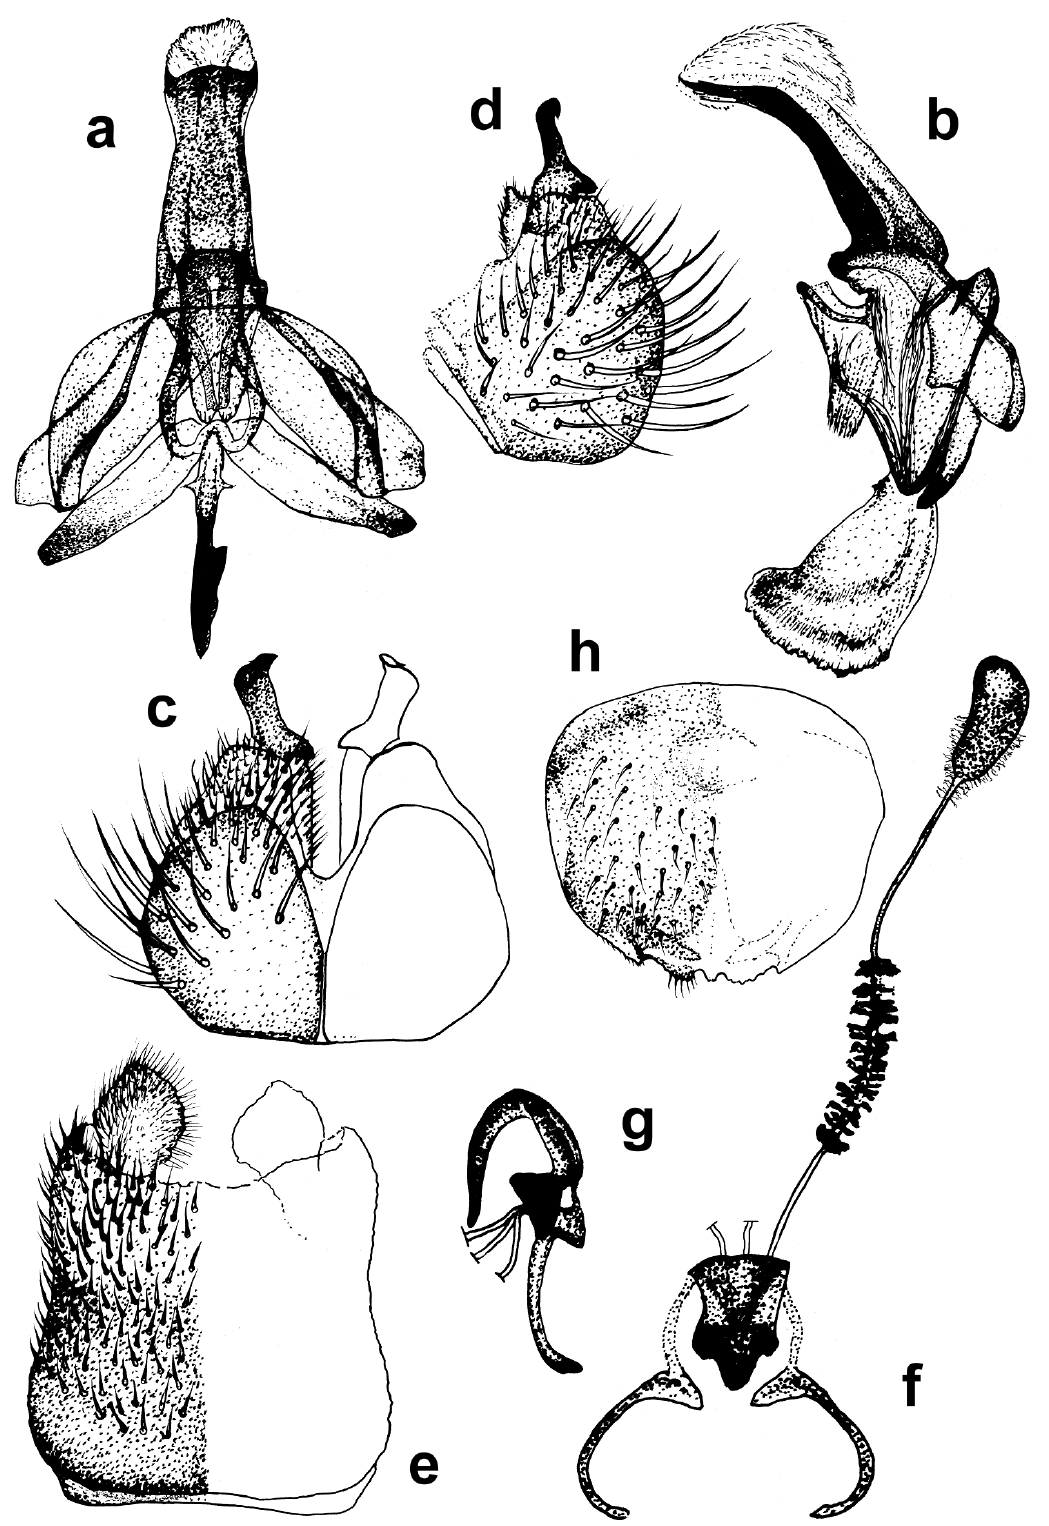
Fig. 55. Protypusia raydahensis (El-Hawagry & Al Dhafer, 2016) gen. et comb. nov. a . Epiphallic complex ventral. b . Epiphallic complex lateral. c . Gonocoxite ventral. d . Gonocoxite lateral. e . Epandrium dorsal. f . Female genitalia ventral. g . Female genitalia lateral. h . Female sternite 8